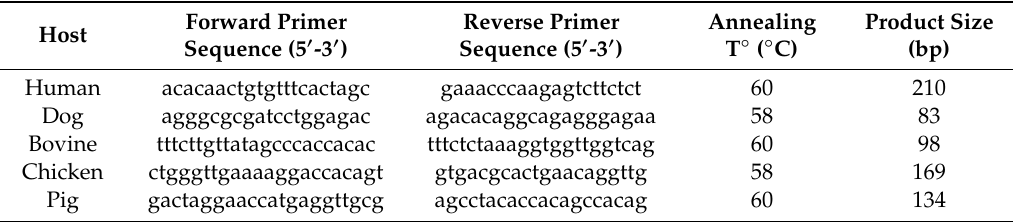
Table 1. Primers, annealing temperature and product sizes of PCR